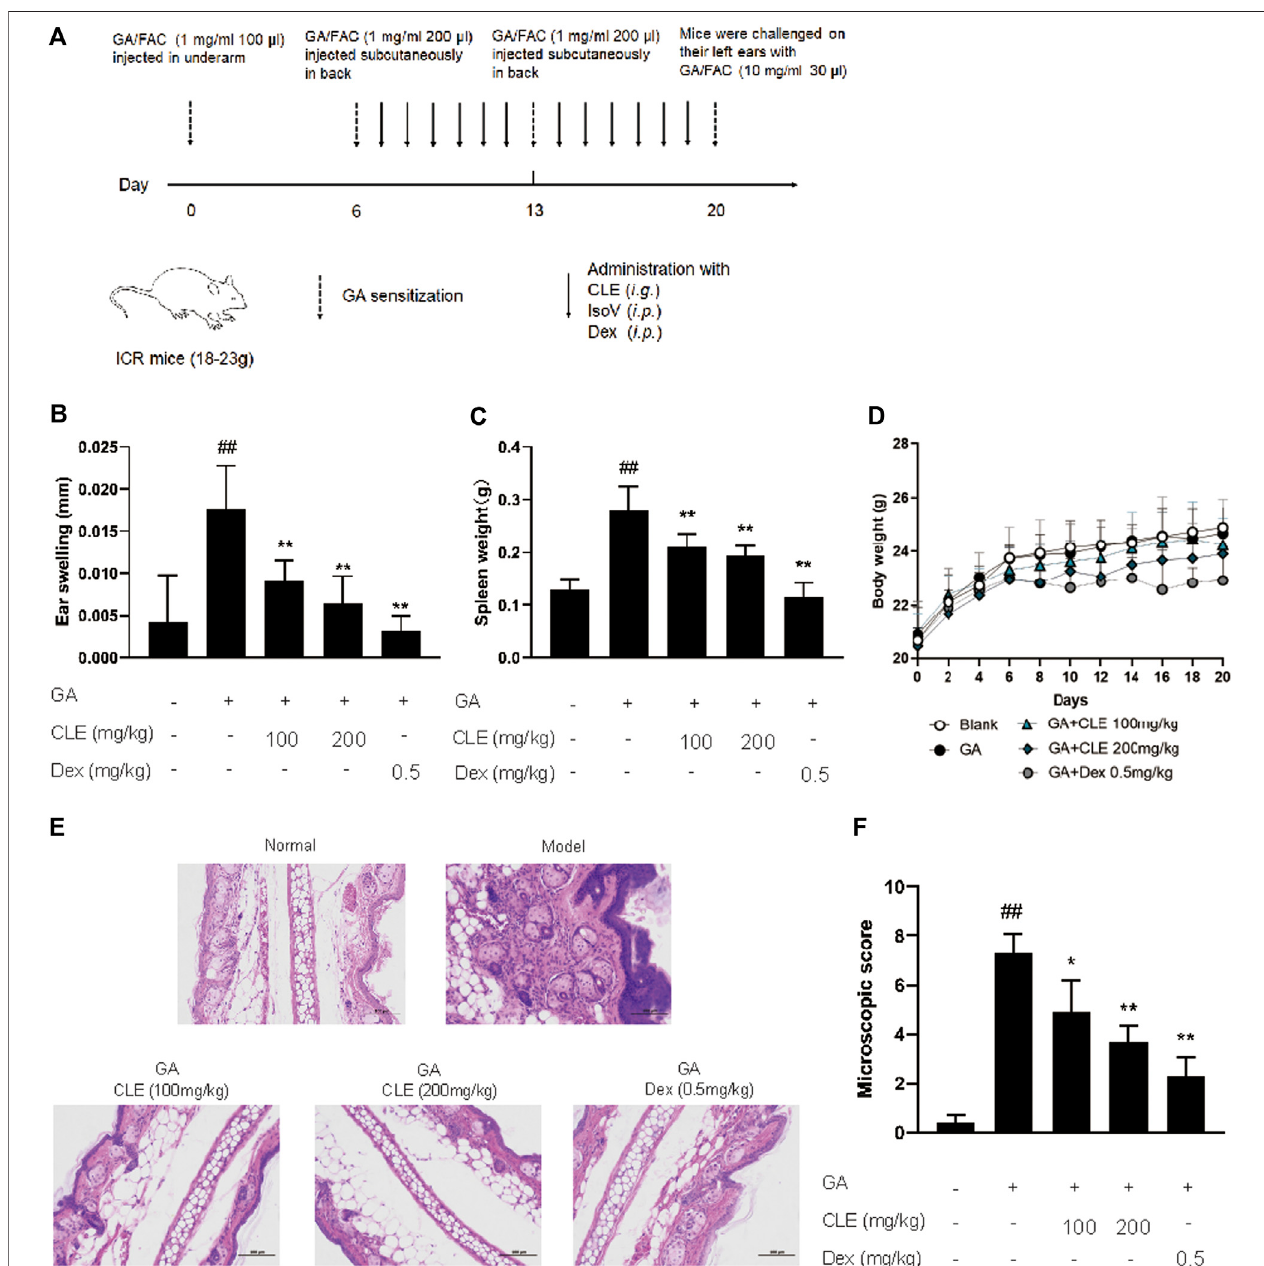
FIGURE 1 | Isovitexin decreases the susceptibility of GA-induced contact dermatitis in mice. In the mouse model of GA-induced contact dermatitis, mice were given isovitexin, a main fl avonoid compound from CEL, at 10 and 20 mg/kg respectively. (A) Chemical structural of isovitexin. (B) The ear swelling was measured at day 20. (C) Spleenweightwasmeasuredatday 20. (D) Thebodyweightchanges ofmiceindifferent groups. (E) Hematoxylin and eosin stain (originalmagni fi cation × 200)ofear tissue sections.Bars,100 µm. (F) Earhistologicalscoring.IsoV,isovitexin.Datarepresentedmeans ± SEMofeightmice. ## p < 0.01vs.vehiclegroup,* p < 0.05,** p < 0.01vs. model